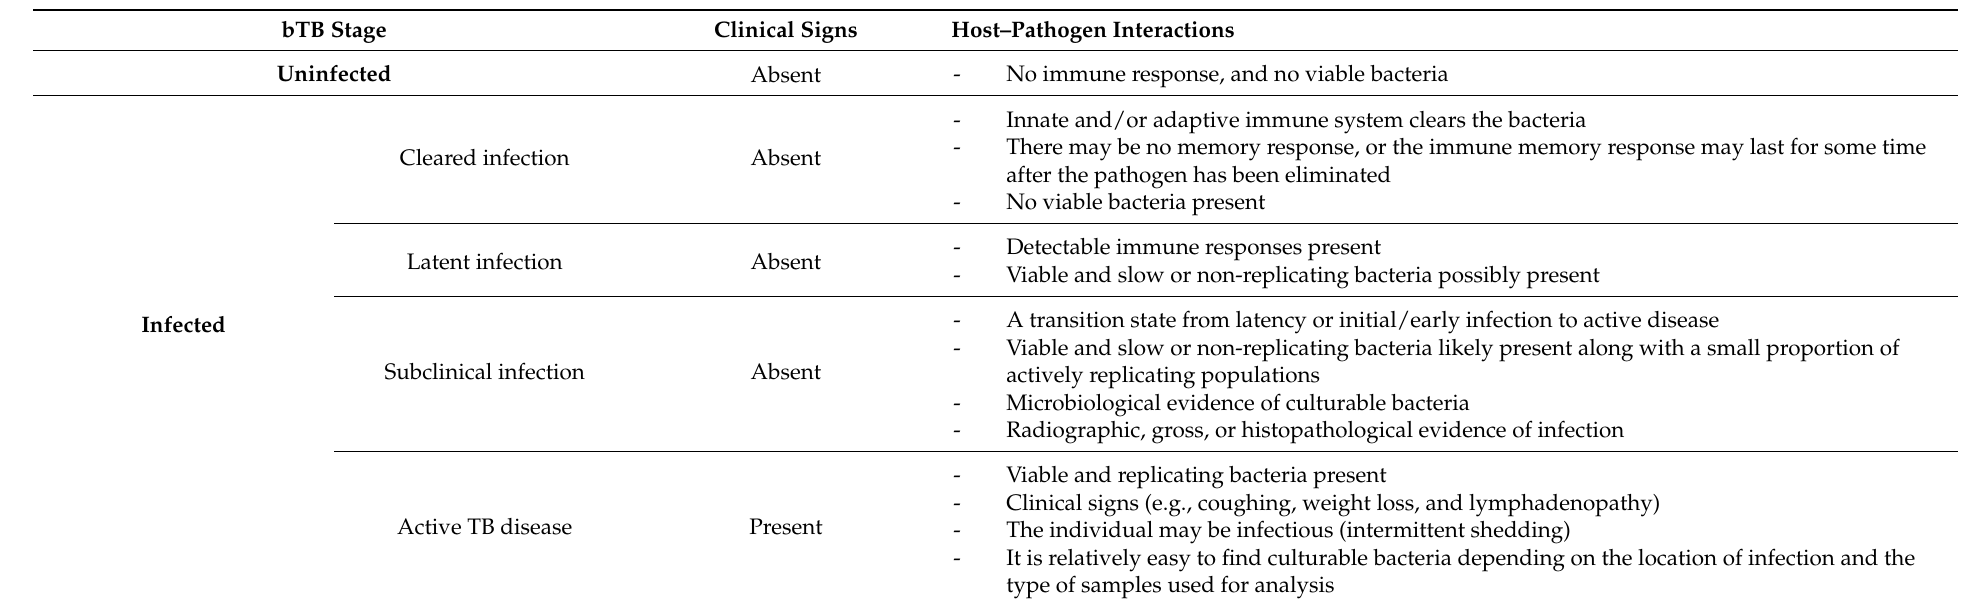
Table 2. Hypothetical stages of mycobacterial infection and host–pathogen interactions in domestic and wild animals. Infection stages may vary in different species depending on the host’s immune response and risk factors, as well as strain and infecting dose of Mycobacterium bovis . (Adapted and adjusted from